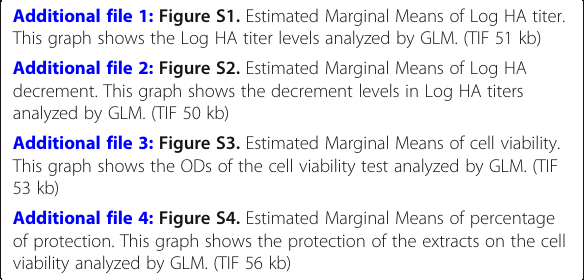
Additional file 4: Figure S4. Estimated Marginal Means of percentage of protection. This graph shows the protection of the extracts on the cell viability analyzed by GLM. (TIF 56